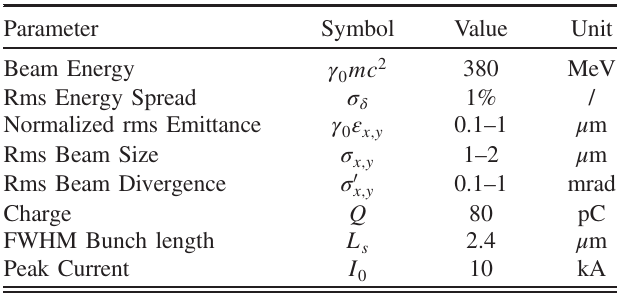
TABLE I. The parameters of the LPA beam for SIOM facility